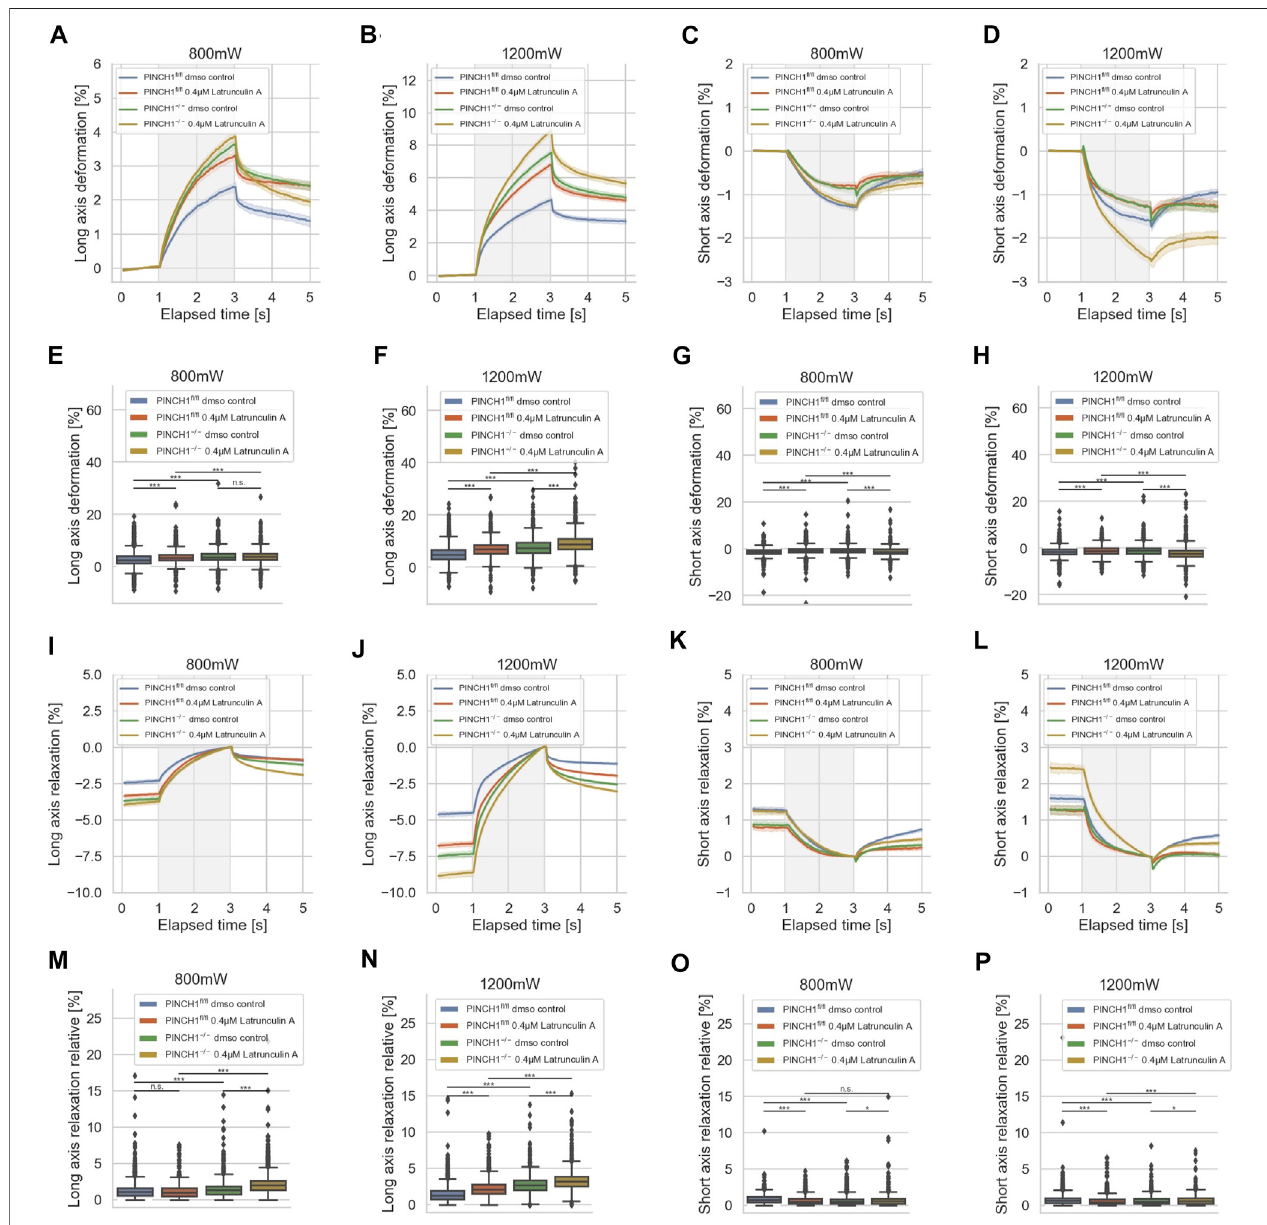
FIGURE4| Effect ofLatrunculinAon cellulardeformability. Cellular deformability ofPINCH1 − / − cellsand PINCH1 fl / fl cells weremeasured at800 mWlaserpower in the presence (median values, n = 1,683 cells for PINCH1 − / − cells (yellow) and n = 1,630 cells for PINCH1 fl / fl cells (red), respectively) or absence of Latrunculin A (median values, n = 1,596 cells for PINCH1 − / − cells (green) and n = 1,641 cells for PINCH1 fl / fl cells (blue) and at 1,200 mW in the presence of Latrunculin A (median values, n = 1,778cellsforPINCH1 − / − cells(yellow)and n =1,697cellsforPINCH1 fl / fl cells(red))orintheabsenceofLatrunculinA(medianvalues, n =1,583cellsforPINCH1 − / − cells(green)and n =1,687cellsforPINCH1 fl / fl cells(blue)usinganopticalcellstretcher.ThedeformabilitycurvesofPINCH1 − / − cellsandPINCH1 fl / fl cellsattheirlongaxis (A,B) , and short axis (C,D) with/withoutLatrunculin A treatment. (E – H) Maximal deformability ofPINCH1 − / − cells and PINCH1 fl / fl cells at laser powers of800 – 1,200 mW at their long (E,F) and short axis (G,H) in the presence or absence of Latrunculin A treatment. After the stretching process, the viscoelastic relaxation is observed for 2 s (I – P) . Relaxation behavior curves of the long axis for PINCH1 − / − cells and PINCH1 fl / fl cells at laser powers of 800 mW (I) and 1,200 mW (J) with/without Latrunculin A treatment. (K,L) Short axis relaxation curves of PINCH1 − / − cells and PINCH1 fl / fl cells at the two laser powers with/without Latrunculin A treatment. (M,N) Maximal relaxation(attimepoint3 s,wherethedeformationismaximal)ofPINCH1 − / − cellsandPINCH1 fl / fl cellsatthetwolaserpowersattheirlongaxiswith/withoutLatrunculinA treatment. (O,P) MaximalrelaxationofPINCH1 − / − andPINCH1 fl / fl cellsatthetwolaserpowersattheirshortaxiswith/withoutLatrunculinAtreatment. (A – D,I – L) Dataare presented as median values with a 95.0% con fi dence interval, (E – H, M – P) data are presented as box and whiskers plots (Q2 represent median values). (A – P) The experiments have been conducted as 4 to 6 independent repetitions. (*** p < 0.001, * p < 0.05, n.s. = not signi fi cant; Kruskal-Wallis test).